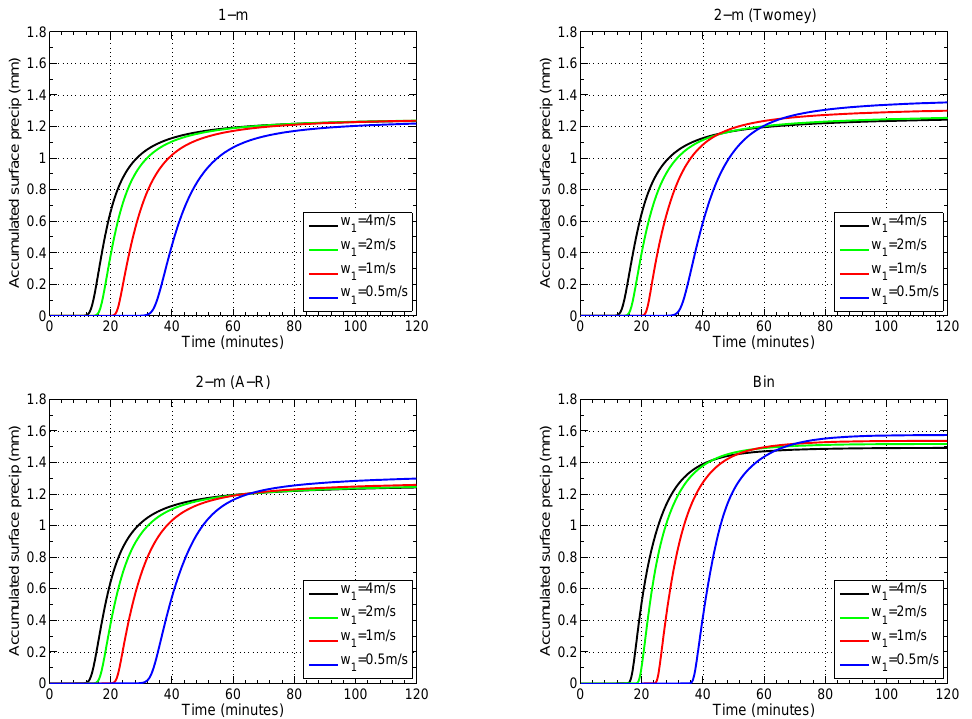
Fig. 8. Timeseries of accumulated surface precipitation (mm) from each scheme. Clockwise from top left: 1-m, 2-m Twomey, bin, 2-m A-R. Results are shown with CCN=100/cc and T =RICO, for four different values of w 1 .